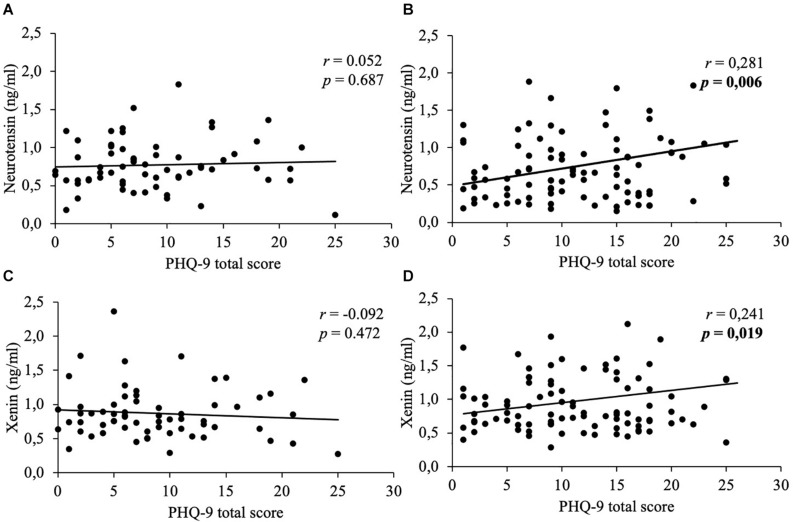
Correlations between neurotensin and xenin with PHQ-9 total scores in men and women. Overall, in women neurotensin (B) and xenin (D) showed a positive correlation with PHQ-9 total score. However, for men no significant correlations with PHQ-9 total score were detected, neither for neurotensin (A) nor for xenin (C). Correlations were calculated using Pearson’s analysis. PHQ-9, Patient Health Questionnaire-9.